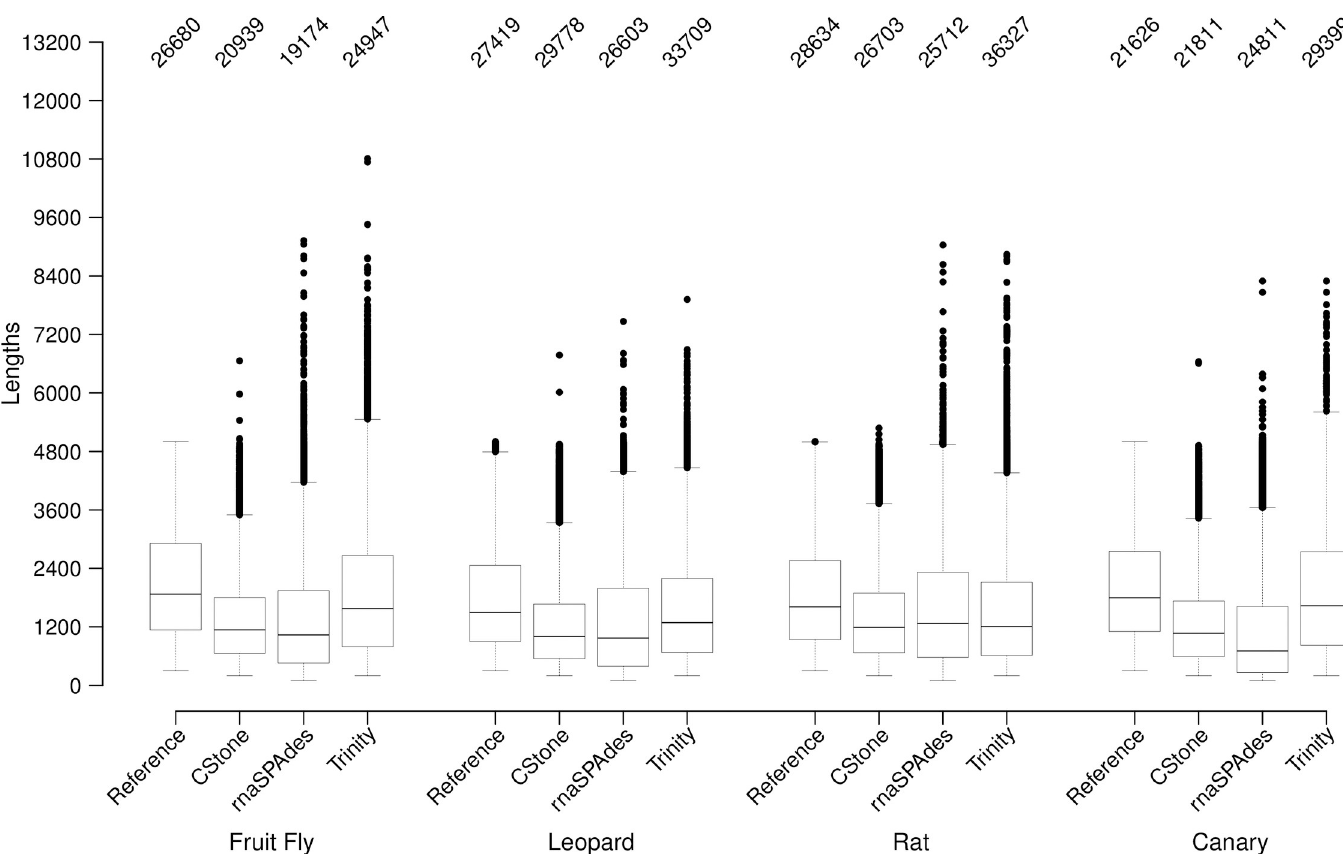
Fig 4. Overall length of contigs and the cDNA reference transcripts from which the reads were simulated. Dataset source along, with the species, is indicated along the x-axis. The numbers on the top indicate the total number of sequences present. Boxes represent the lengths falling within the inter quartile ranges. The median is shown within each box. Whiskers extend to the furthest data point that is within 1.5 times the inter quartile range and points beyond this are outliers (black circles). Outlier numbers are indicated in Table 3.